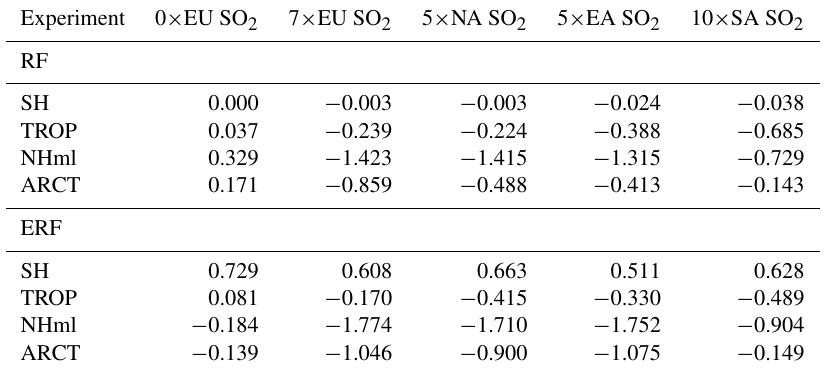
Table 4. Regional radiative forcing (RF) and effective radiative forcing (ERF) in Wm − 2 used to derive latitudinal ARTPs in Figs. 11–14.